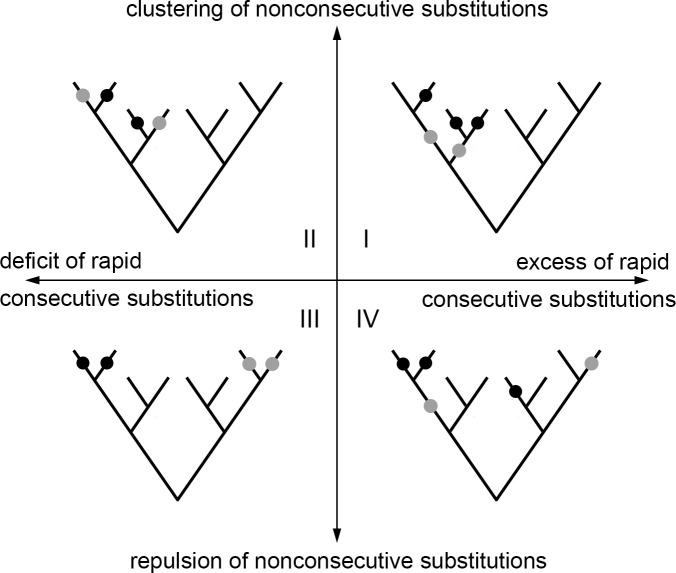
Distinguishing between additive and epistatic episodic selection.Each pair of sites can be characterized by excess or deficit of rapid substitutions in the same lineage (horizontal axis), vs. clustering or repulsion of substitutions in different lineages (vertical axis). On the scheme, substitutions at one of the two considered sites are shown in black, and substitutions at the other are shown in gray. An excess of rapid consecutive substitutions accompanied by clustering of nonconsecutive substitutions (quadrant I) implies concurrent episodic selection and can be observed without any epistatic interactions between sites. Analogously, a deficit of rapid consecutive substitutions accompanied by repulsion of nonconsecutive substitutions (quadrant III) implies episodes of selection that are distinct between the two sites and does not necessarily require epistasis. By contrast, an excess of rapid consecutive substitutions together with repulsion of nonconsecutive substitutions (quadrant IV) cannot be explained by episodic selection alone and is indicative of positive epistasis. Similarly, a deficit of rapid consecutive substitutions along with clustering of nonconsecutive ones indicates negative epistasis.